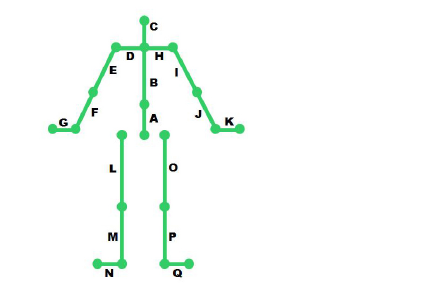
Figure 2. The skeleton extracted by the Kinect application: 20 joints are